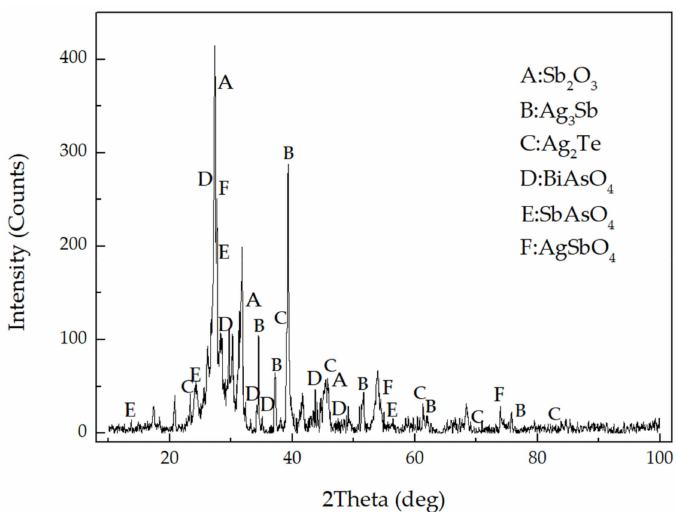
Figure 1. XRD (X-ray diffraction) pattern of TLAS (tellurium-rich lead anode slime).